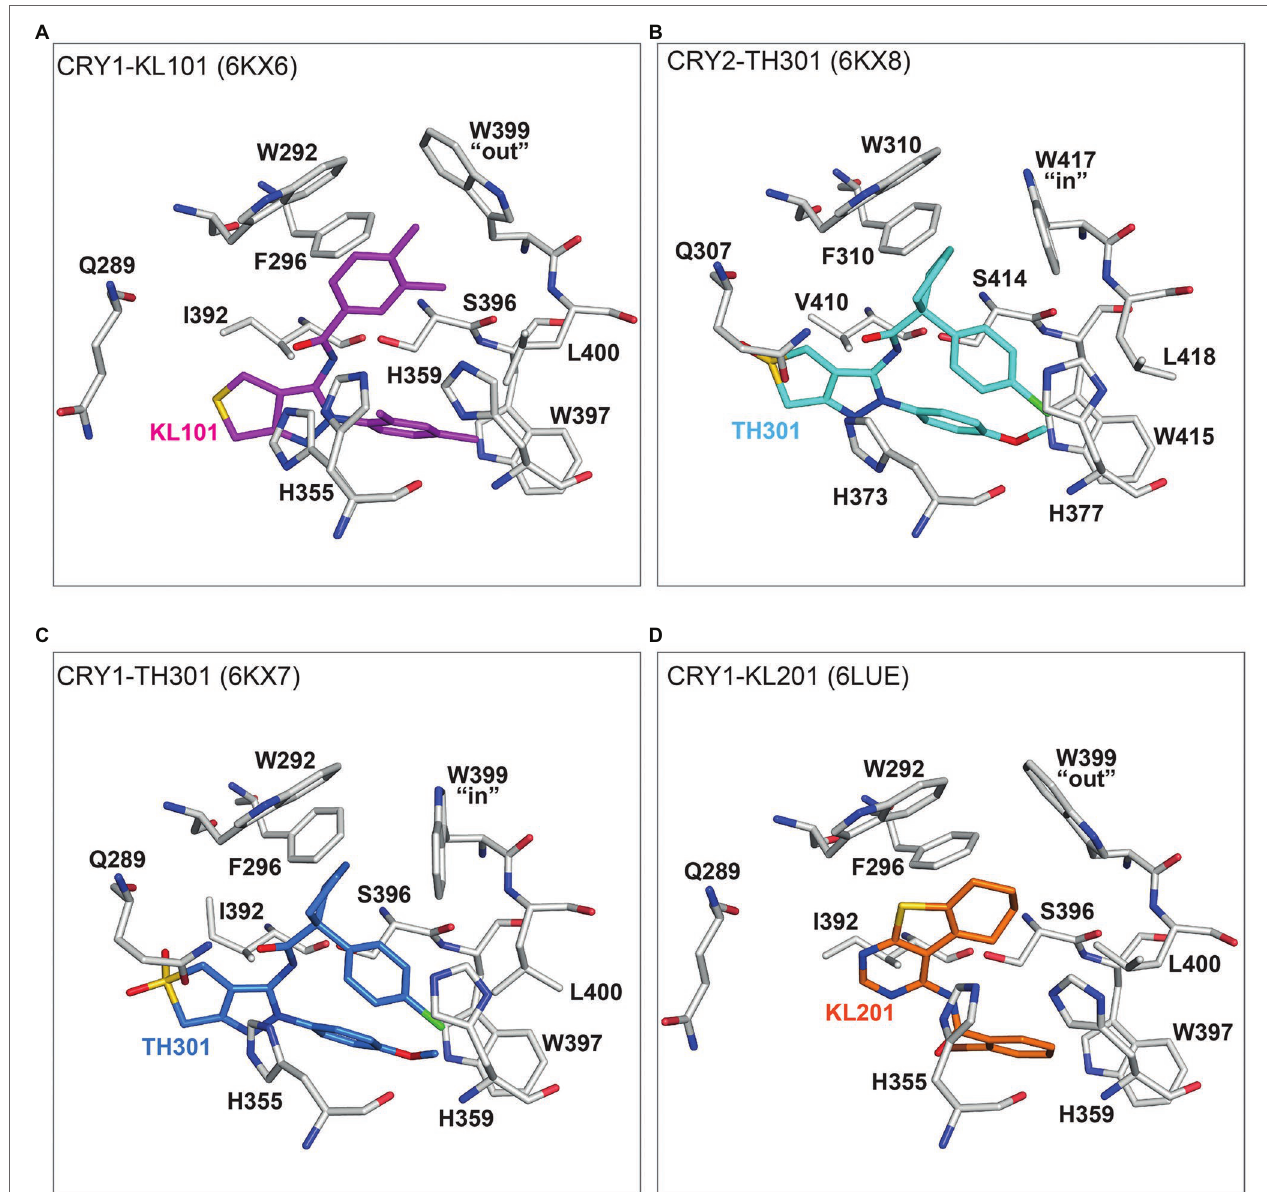
FIGURE 5 | Binding modes of isoform-selective compounds in CRY1 and CRY2. (A) Crystal structure of CRY1-KL101 (PDB ID: 6KX6). Key interacting residues (white) and the KL101 compound (magenta) are shown. The upper dimethylphenyl located in hydrophobic region 1 and fitted to an intrinsically “out” gatekeeper W399 conformation. The lower dimethylphenyl located in hydrophobic region 2 and formed hydrophobic interactions with W397. H355 was not restrained by KL101 binding and transiently adopted the same conformation observed in CRY1-PG4 ( Figure 4 ) and CRY1-KL201 (D) . (B) Crystal structure of CRY2-TH301 (6KX8). The cyclopentyl group of TH301 (cyan) binds in hydrophobic region 1 and forms a stacking interaction with the intrinsically “in” conformation of gatekeeper W417 (white). The methoxyphenyl group (in hydrophobic region 2) forms a hydrogen bond with W415. H373 adopted the same conformation as in CRY2-apo ( Figure 4 ). (C) The binding of TH301 (blue) to CRY1 (white) induces a conformational change in CRY1-TH301 (6KX7). The small steric bulk of the cyclopentyl of TH301 induced a stacking interaction with the gatekeeper W399, which rotated from an intrinsic “out” conformation to an “in” conformation. The conformational freedom of H355 is restricted by the methoxyphenyl group, preventing H355 adopting a conformation observed in CRY1-KL101 (A) and CRY1-PG4 ( Figure 4 ). (D) A unique binding mode of KL201 (orange) to CRY1 (white) in CRY1-KL201 (6LUE). The fused tricyclic thienopyrimidine and cyclohexyl moiety of KL201 binds to hydrophobic region 1 of the FAD pocket. In this configuration, the compound fits to an intrinsically “out” gatekeeper W399 conformation. H355 adopted a stable conformation similar to CRY1-PG4 ( Figure 4 ) and CRY1-KL101 (A) , but distinct from CRY1- TH301 (C) . The bromophenyl group (essential for compound effect) located in hydrophobic region